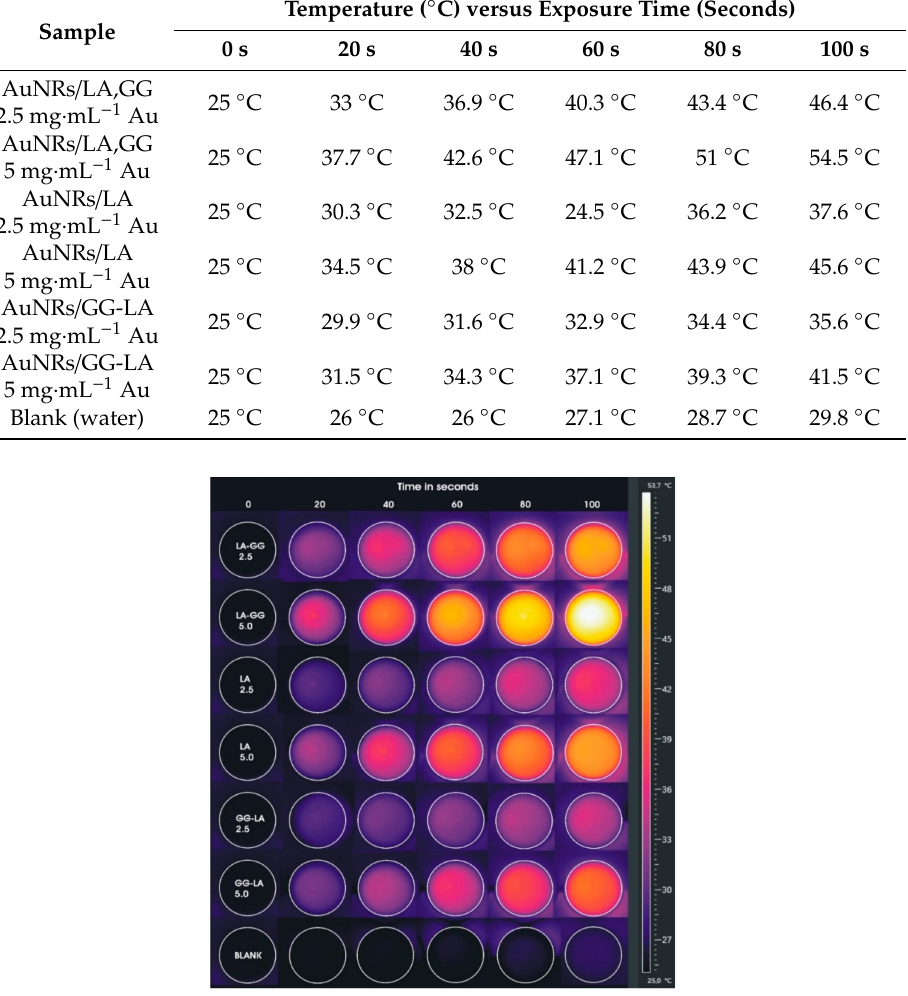
Table 4. Maximum temperatures recorded by thermal imaging camera during hyperthermia studies in 24-well plates (laser power of 10 × 10 − 3 W / mm 3 ) of AuNRs / LA,GG, AuNRs / LA, and AuNRs / GG-LA samples corresponding to gold concentrations of 2.5 and 5 µ g · mL − 1 .